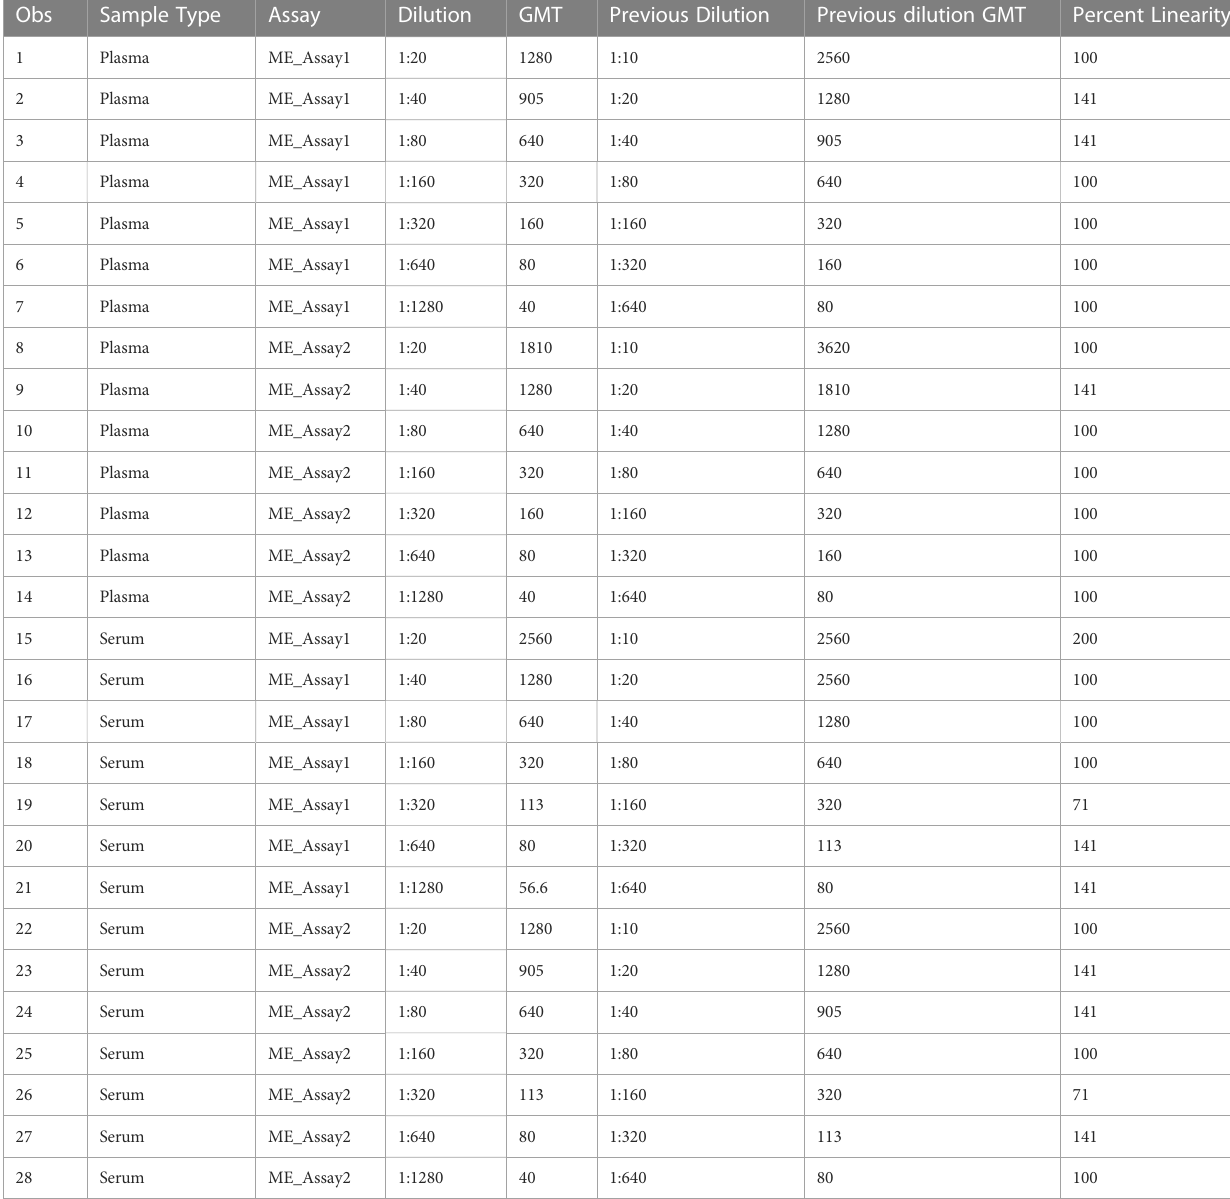
TABLE 2 HAI assay quali fi cation on H3N2 in fl uenza strain A/Texas/71/2017, matrix effect testing, percent linearity results. Obs Sample